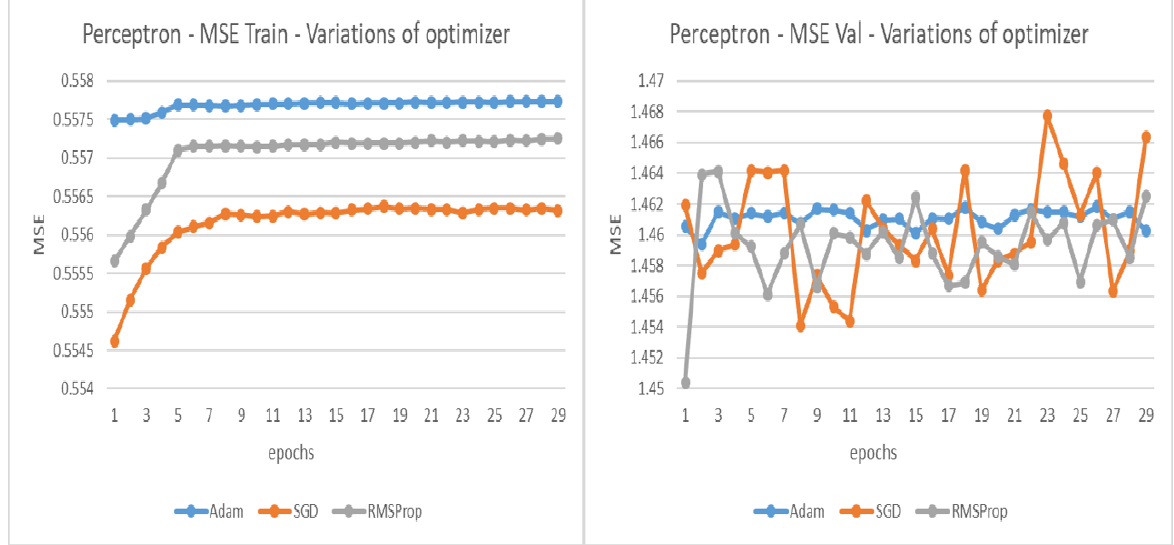
Figure 13. Source: Comparative results of tests on the optimizer variation. Own elaboration.